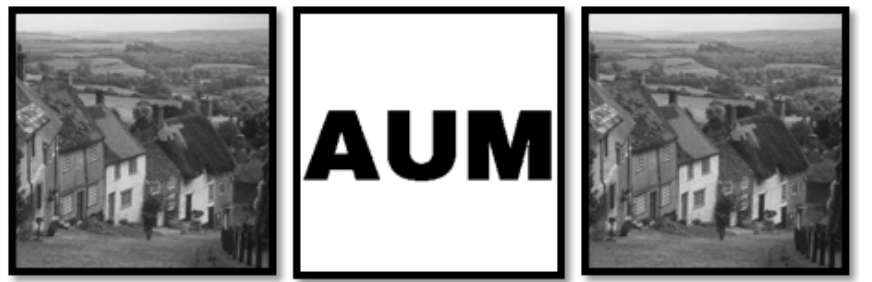
Figure 3. Cover image, binary watermark and watermarked